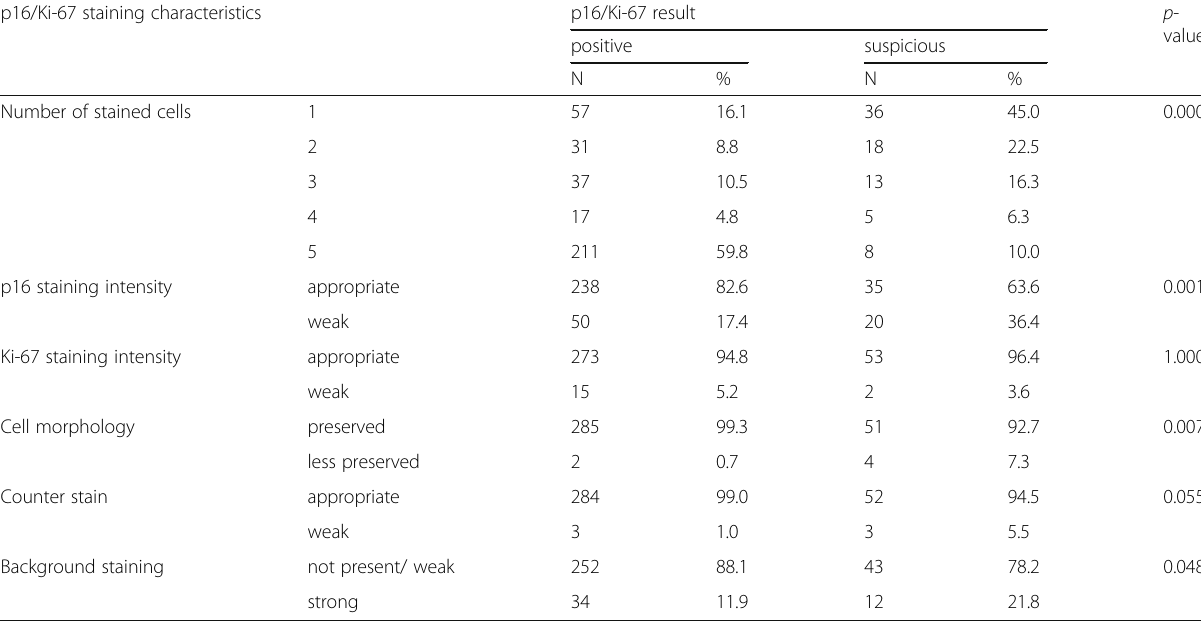
Table 3 Characteristics of p16/Ki-67 dual staining in suspicious and positive recordings p16/Ki-67 staining